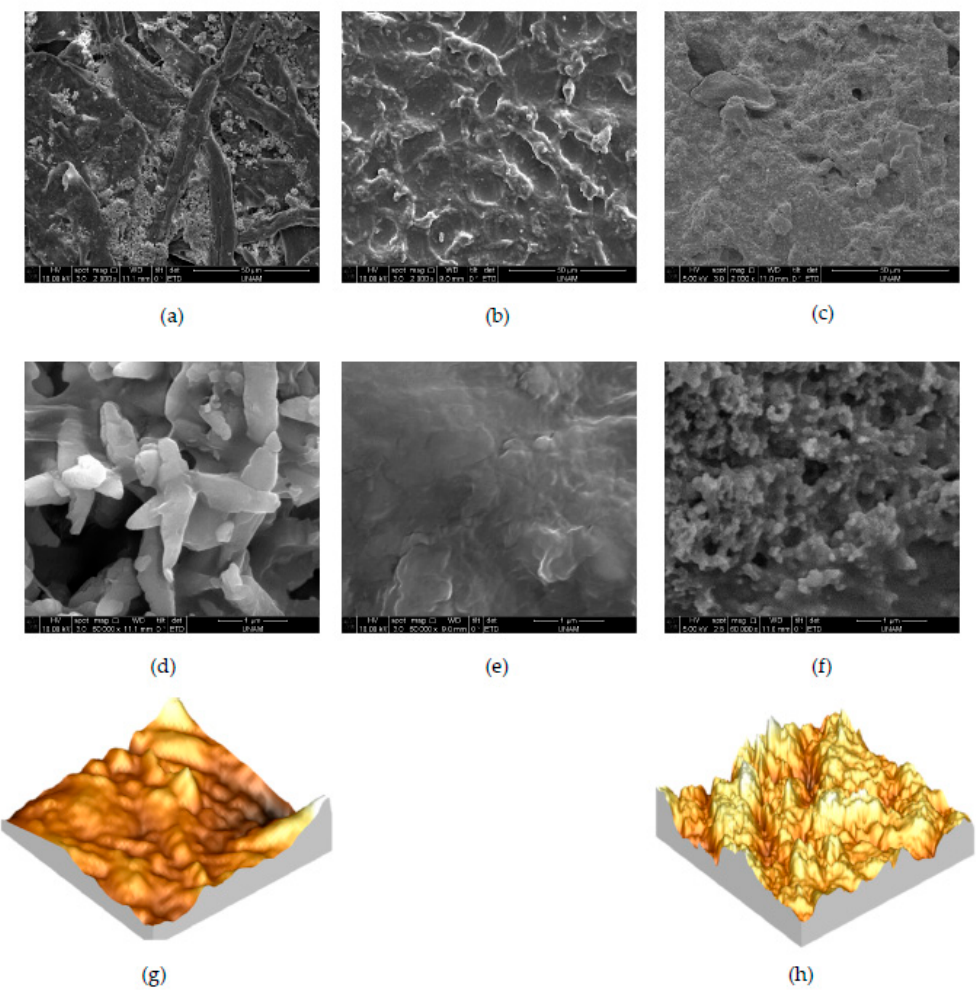
Figure 6. SEM images of ( a – d ) cellulose paper ( b – e ) PVA ( c – f ) CB/PVA composite on cellulose paper, and 3D AFM images of ( g ) the blank cellulose paper (image dimensions 5 µm × 5 µm) and ( h ) the CB/PVA composite ink screen-printed on cellulose paper (image dimensions 10 µm × 10 µm).